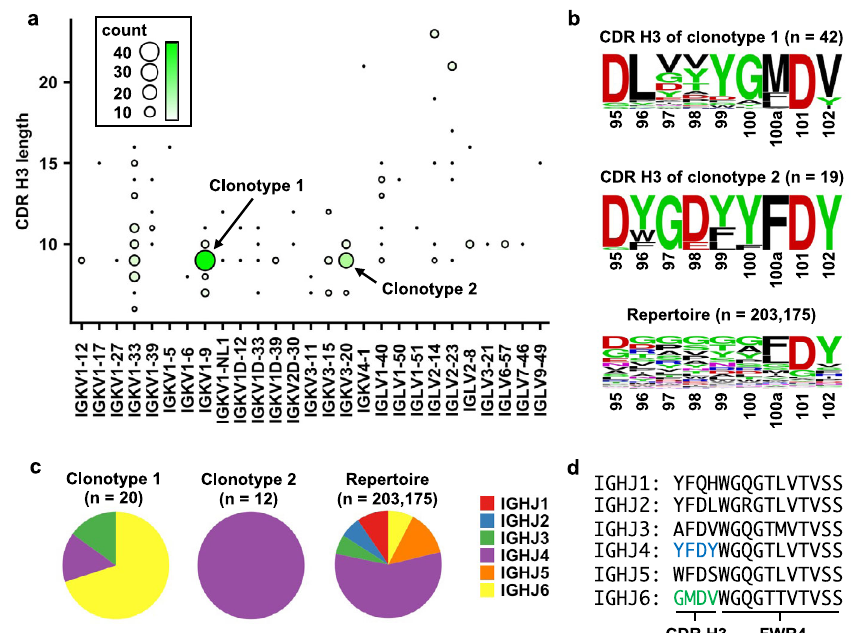
Fig. 1 Two major clonotypes of IGHV3-53/3-66 antibodies to SARS-CoV-2 RBD. a The number of IGHV3-53/3-66 RBD antibodies that use the same light chain with the same CDR H3 are tabulated. The two most common combinations are IGKV1-9 pairing with 9 aa CDR H3 and IGKV3-20 pairing with 9 aa CDR H3, denoted as clonotype 1 and clonotype 2, respectively. b Sequence logos for the CDR H3 regions of IGHV3-53/3-66 antibodies that pair with IGKV1-9 or IGKV3-20. A sequence logo for the CDR H3 regions of 203,175 IGHV3-53/3-66 antibodies from Observed Antibody Space database 91 that have a CDR H3 length of 9 aa is shown for reference (repertoire). The position of each residue is labeled on the x -axis based on Kabat numbering. c IGHJ gene usage for clonotypes 1 and 2, as well as 203,175 IGHV3-53/3-66 antibodies from Observed Antibody Space database that have a CDR H3 length of 9 aa (repertoire), are shown as pie charts. For antibodies in clonotypes 1 and 2, only those with nucleotide sequence information available were analyzed. d Amino acid sequences for different IGHJ genes are shown. Source data are available in the Source data fi le.